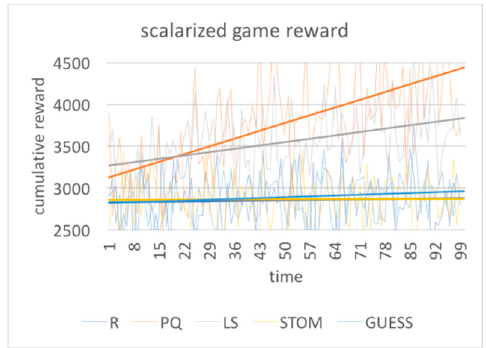
Figure 2. Cumulative reward scalarization over time.